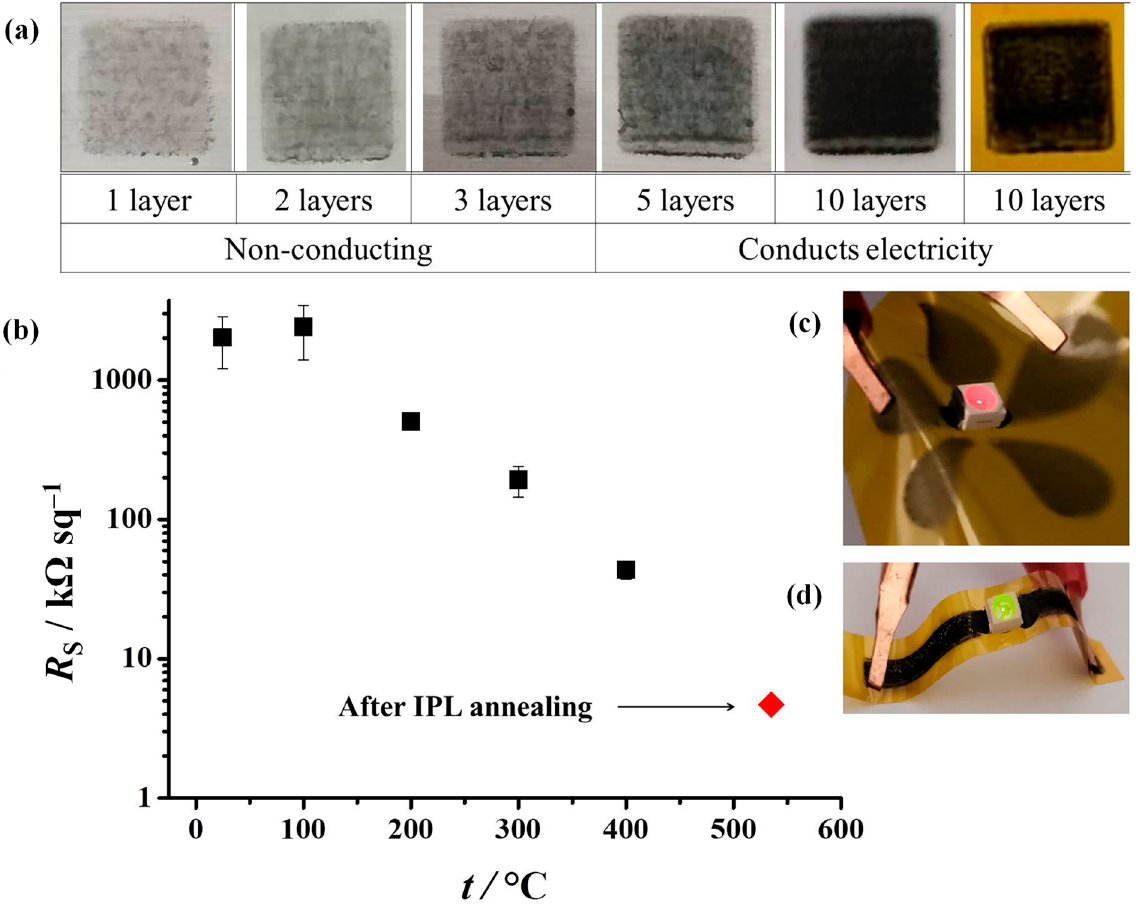
Figure 7. ( a ) The different number of printing passes of the conductive ink on a PET and PI substrate; ( b ) the sheet resistance of printed squares on PI, after thermal annealing at different temperatures. Error bars represent one standard deviation ( n = 6); red diamond indicates the sheet resistance value after intense pulsed light (IPL) annealing at the energy of 700 J; examples of flexible printed electronics using 10 layers ( c ) and 20 layers ( d ) of the M-GNS ink.